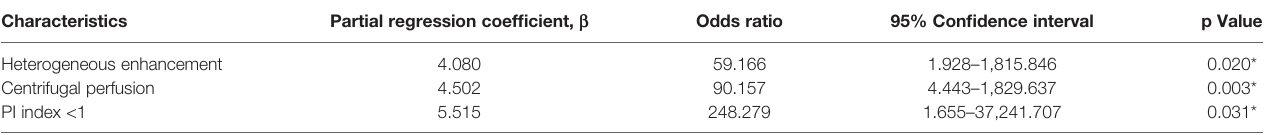
TABLE 3 | Multivariate logistic regression analysis of CEUS characteristics related to PCPTCs distinguishing from nodular goiters. Characteristics